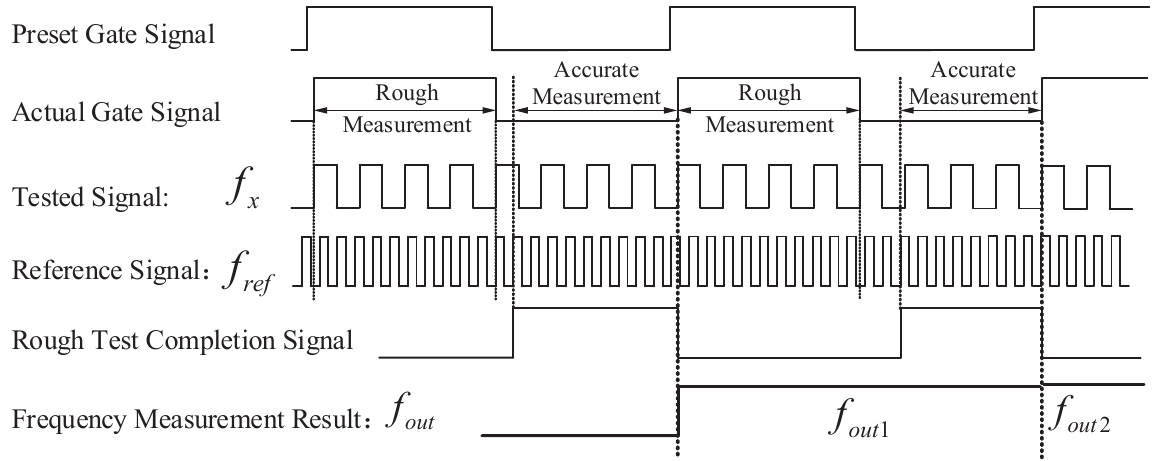
Figure 10. Control timing diagram of the proposed high-precision frequency measurement system based on negative feedback control structure.